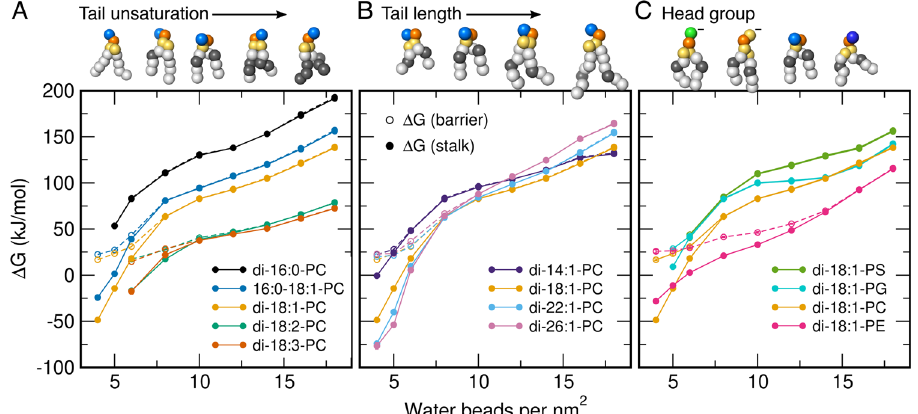
Fig. 4 Impact of tail unsaturation, tail length, and head group. Free energies of stalk formation Δ G stalk (solid circles) for single-lipid membranes composed of various lipid types, plotted as a function of increasing hydration between the proximal lea fl ets. Legends indicate the approximate atomistic correspondence of the Martini models. Open circles show the free energy barrier for stalk formation (if present). Beads of Martini lipid models are colored as follows: hydrophobic saturated (white), hydrophobic unsaturated (gray), glycerol (yellow), phosphate (orange), choline (light blue), serine (green), ethanolamine (dark blue). A Lipids with increasing tail unsaturation, B with increasing tail length, and C with different head groups. Source data are provided as a Source Data fi